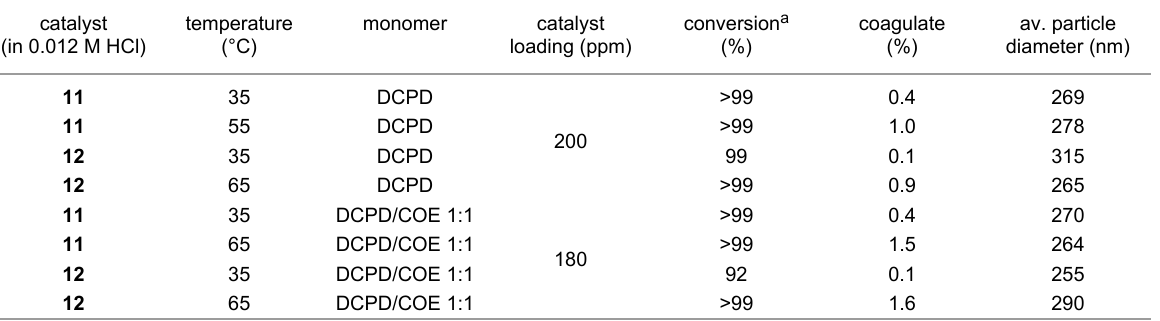
Table 4: Emulsion ROMP of DCPD (Ru/monomer = 1:5.0 × 10 4 ) and DCPD/COE (49:51 (mol/mol) – Ru/monomer = 1:5.6 × 10 4 ) mixtures with cata- lysts 11 and 12 after 120 min reaction time. catalyst (in 0.012 M